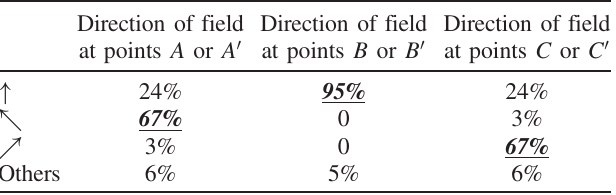
TABLE III. Distribution of student responses for the directions of electric field at various points on pretest question (1) including all sections that took the pretest (after traditional lecture-based instruction) in relevant concepts. The percentages of students who answered the questions correctly are in boldface and